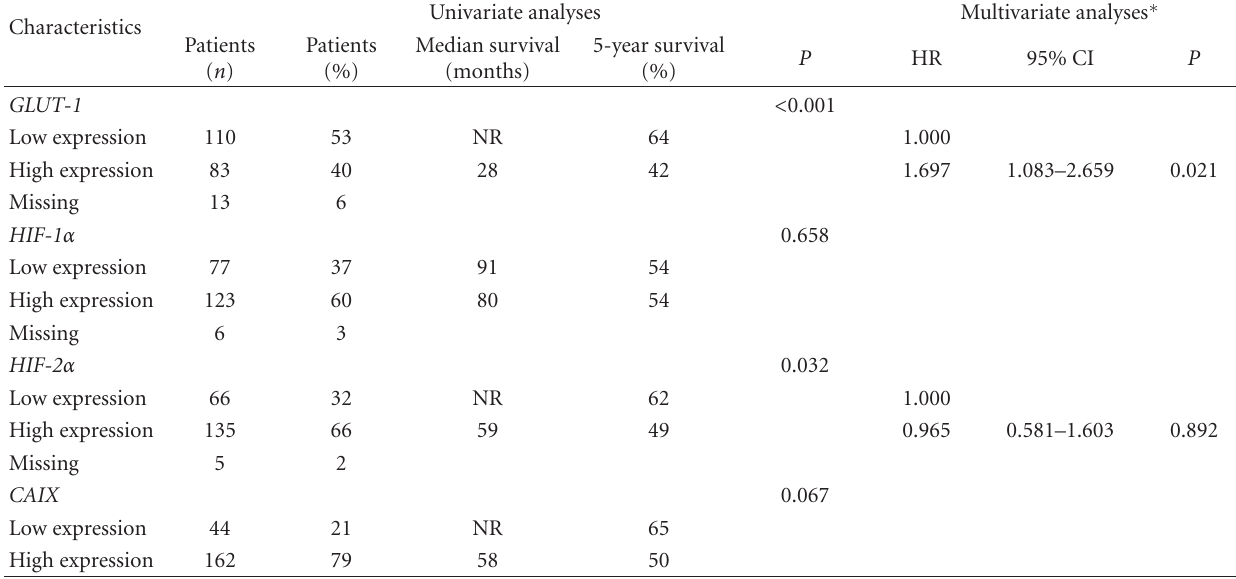
Table 3: Tumor expression GLUT-1, HIF-1 α , HIF-2 α , and CAIX and their prognostic relevance for disease-specific survival in 206 patients with non-gastrointestinal soft tissue (univariate analyses; log-rank test, multivariate analyses; Cox proportional hazards model). Univariate analyses Multivariate analyses Characteristics